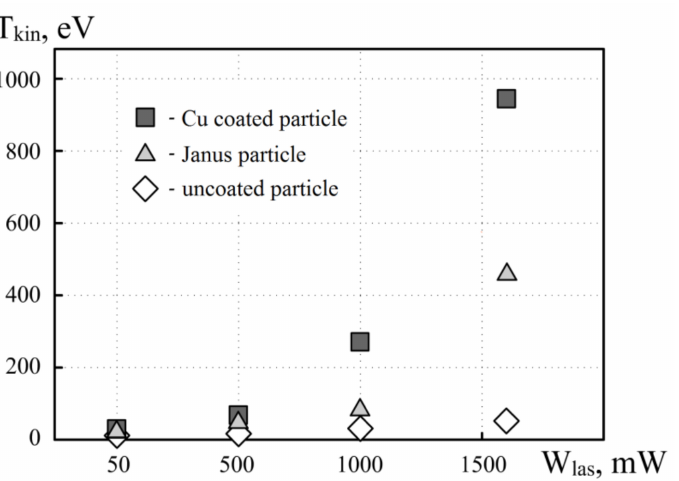
Figure 5. Kinetic energy of a single dust particle under the influence of laser radiation with a power of 50, 500, 1000 and 1600 mW for: uncoated particle, Cu-coated particle, and Janus